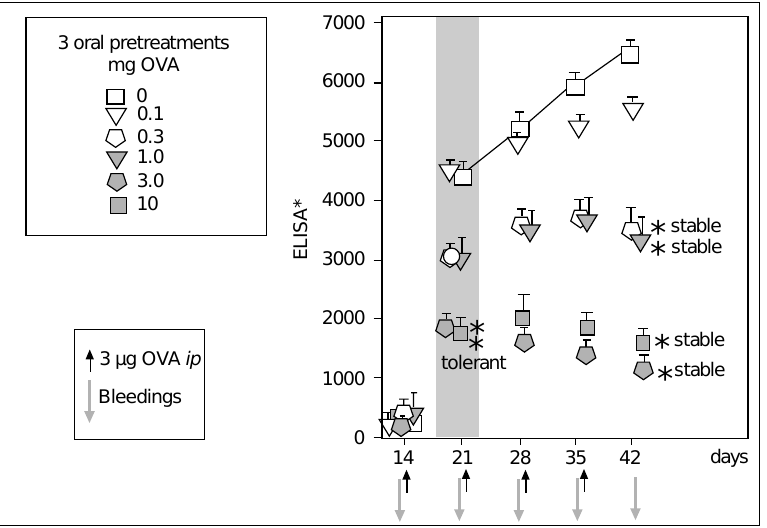
Figure 4 - Effect of repeated oral exposures to antigen on the stabilization of serum antibody responses. Mice received 3 gavages with saline (controls, open squares) or with saline containing either 0.1 mg (open triangles), 0.3 mg (open pentagons), 1.0 mg (filled triangles), 3.0 mg (filled pentagons) or 10 mg OVA (filled squares), 7 days before primary ip immuniza- tion with 10 µg OVA + 1 mg Al(OH) 3 ip ; 14 days later a series of 4 ip weekly challenges with 3 µg soluble OVA was initiated. Immediately before each booster the mice were bled for measurement of antibodies by ELISA. Asterisks indicate significant differences between control and experimental